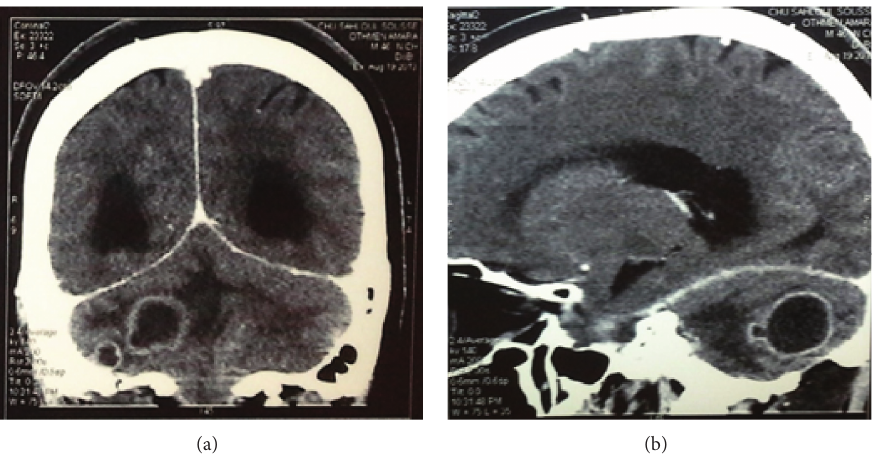
Figure 3: Computed tomography scan: coronal (a) and sagittal (b) views showing 3 cerebellar ring-enhancing mass lesions.